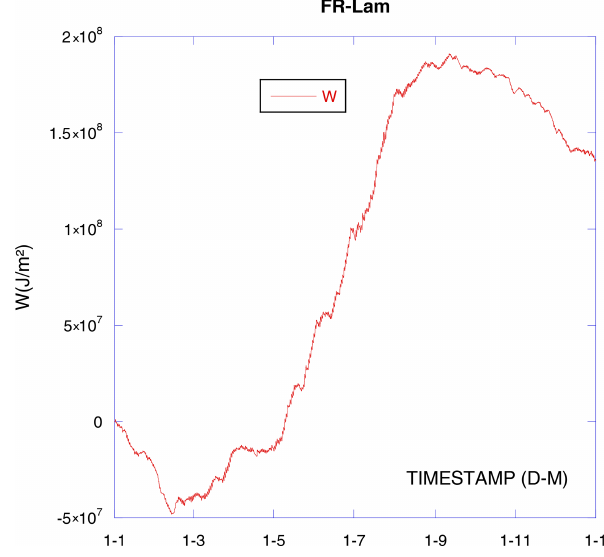
Figure 1. Soil heat flux measured by a self-calibrated heat flux plate, for 1 year.